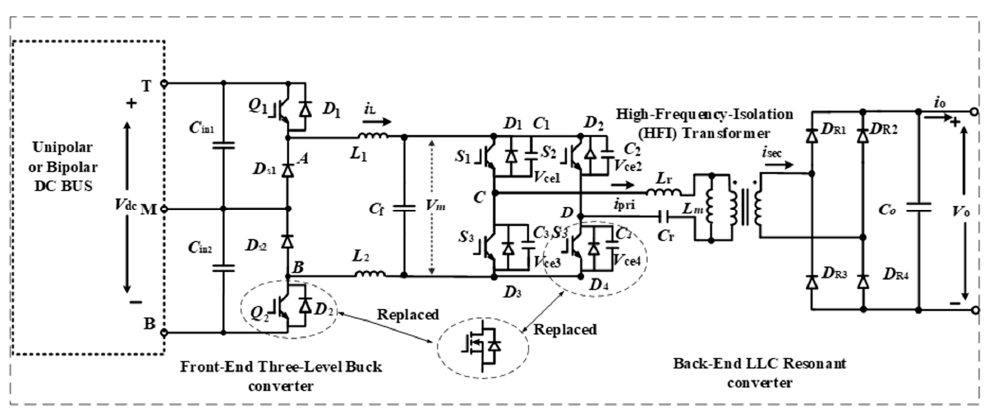
Figure 2. The proposed high-frequency isolation (HFI) charging-port topology based on a front-end three-level converter and a back-end LLC resonant converter.